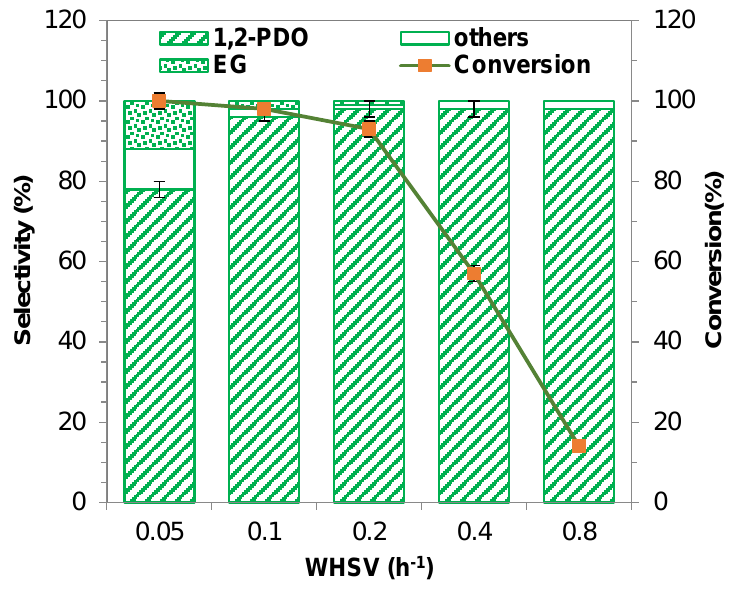
Figure 7. Influence of WHSV (0.05–0.8 h − 1 ) on the performance of 5Cu-1B/Al 2 O 3 catalyst for glycerol